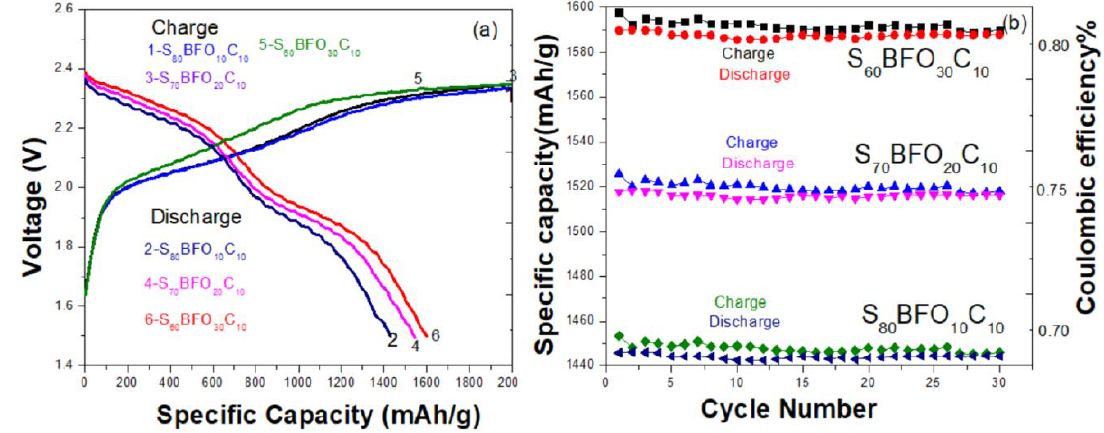
Figure 5. ( a ) Voltage profile and ( b ) Cycling performance for BFO – C-Sulfur composite cathode materials at a C/5 rate.